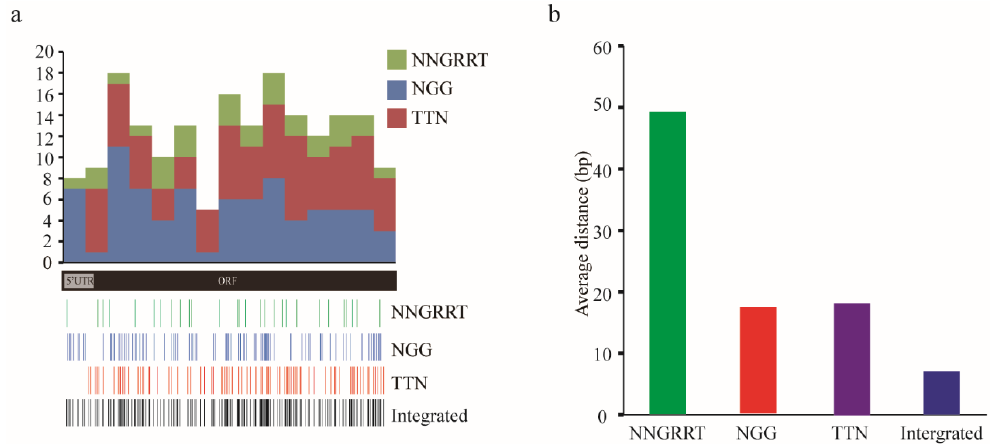
Figure 1. Comparative analysis of CRISPR targeting sites on Amyellow-y mRNA: ( a ) numbers and distributions of targetable sites on Amyellow-y mRNA. The different colours of the top panel indicate the number of different CRISPR target sites. The X -axis indicates the position on Amyellow-y mRNA, and the Y -axis represents the numbers of targeted sites. The middle panel presents the schematic diagram of the Amyellow-y mRNA structure. The Bottom panel is the sketch map of sites distribution. Each line indicates one target site; ( b ) the average distance between two adjacent sites of different CRISPR Insects 2021 , 12 , 954 systems along Amyellow-y mRNA. The X -axis represents the PAM types, and the Y -axis represents the average distances.